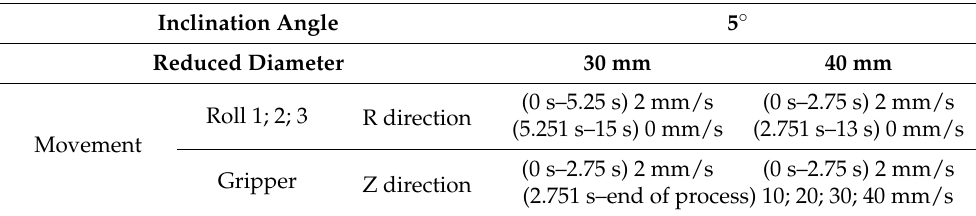
Table 1. The velocity and geometrical parameters selection for numerical analysis (directions R and Z according to Figure